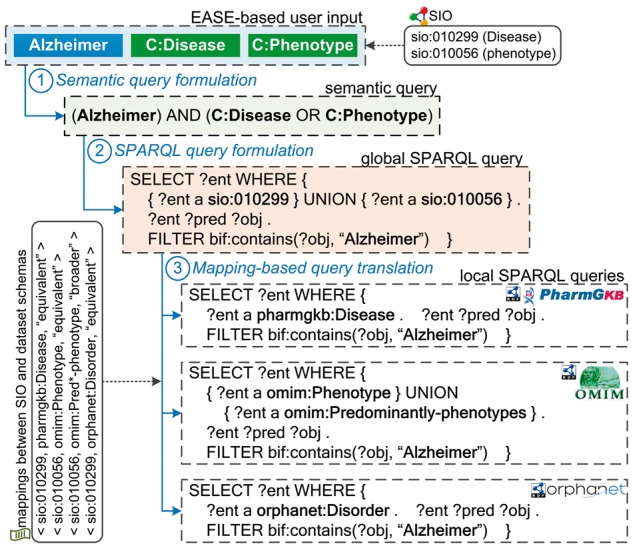
A running example.